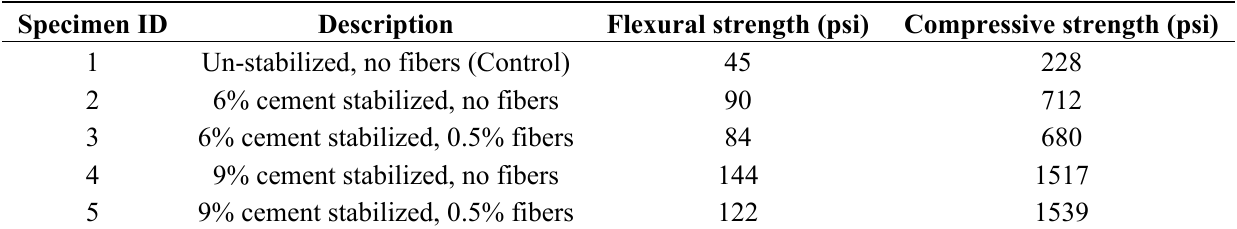
Table 3. Test matrix and results—CSEB Project